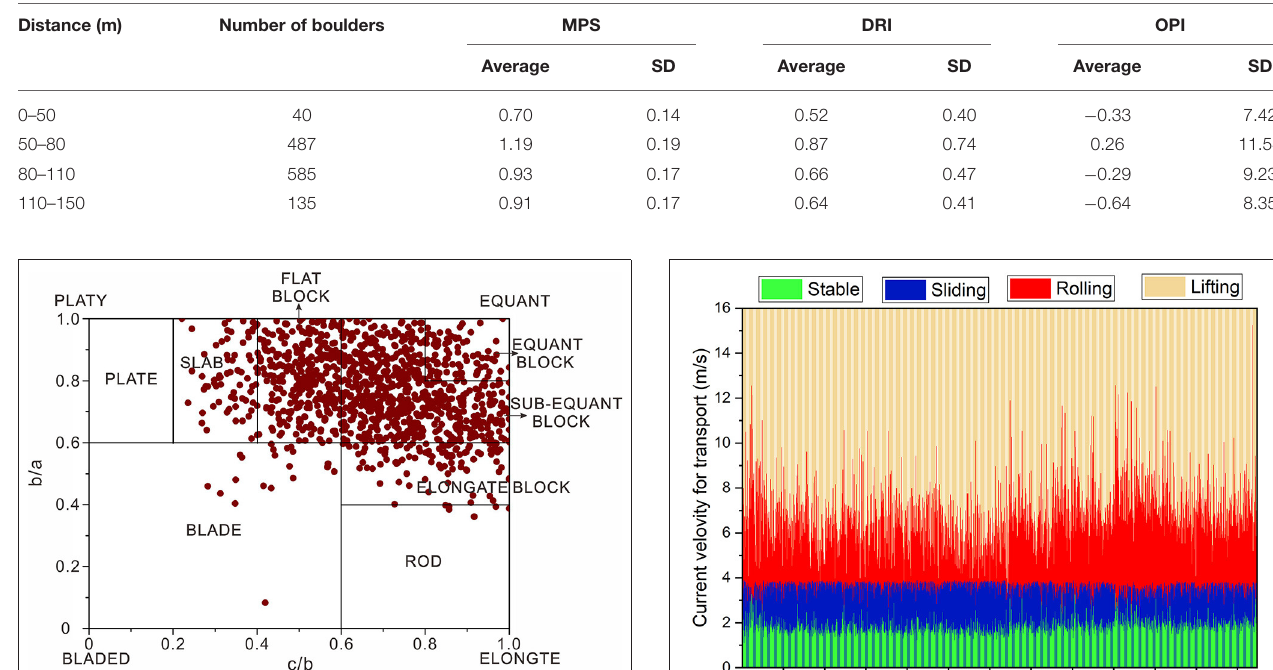
TABLE 4 | Shape parameters and standard deviations (SD) of carbonate boulders.